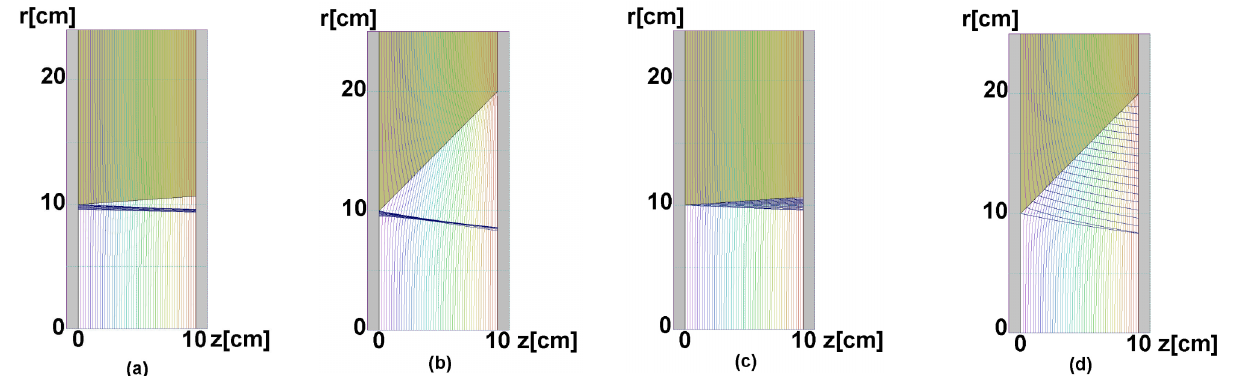
FIG. 1. (Color) Equipotential curves and electron trajectories (rays from left to right) in vacuum in a half cross section of a coned axially symmetric insulator ring (olive colored). The potential is applied between two parallel plates attached to the ends z (cid:5) 0 and 10 cm of the drawn device. Cone angles are 3 : 8 (cid:4) [in (a) and (c)], 45 (cid:4) [in (b) and (d)], h E ray traced trajectories of electrons emitted on the cathode surface near the triple junction are drawn. In (c) and (d), trajectories of electrons originating on the surface of the insulator are